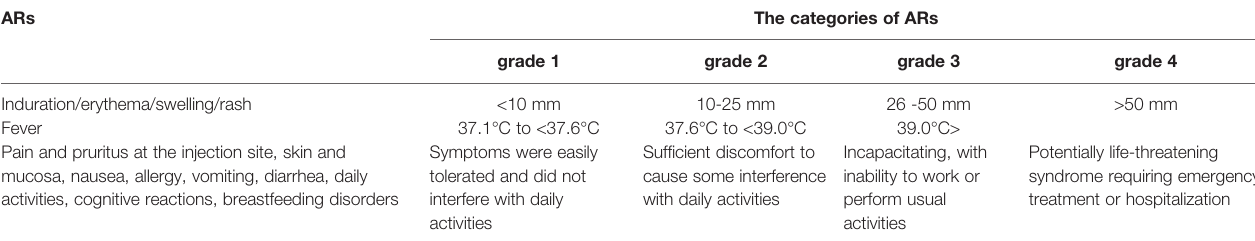
TABLE 1 | The categories of ARs (adverse reactions) after vaccination.